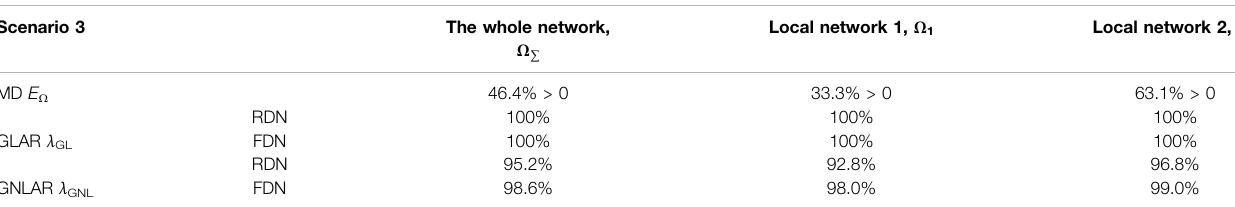
TABLE 4 | Matching degree and daily accommodation ratio of scenario 3. Scenario